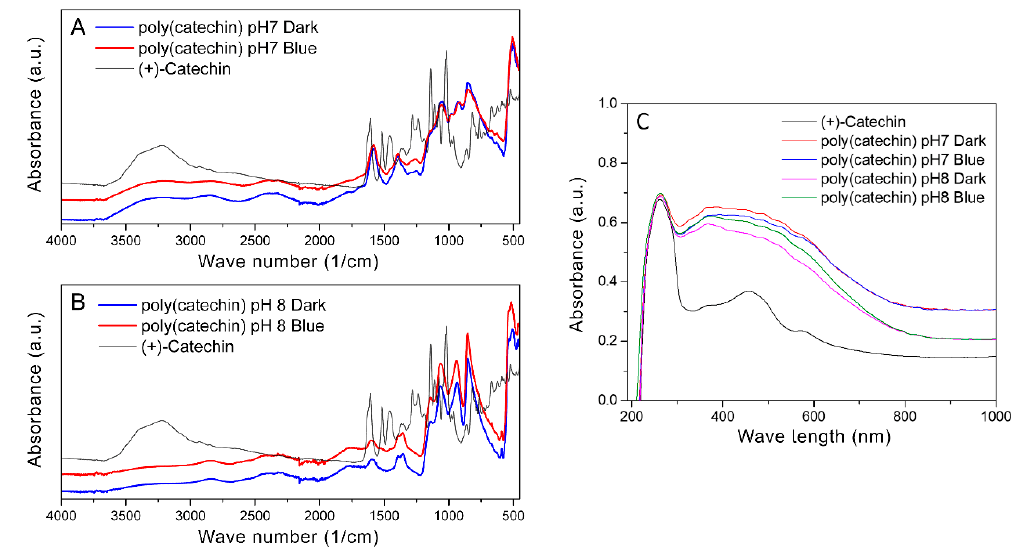
Figure 3. FTIR (Fourier-transform infrared spectroscopy) spectra of poly(catechin) powders obtained as a result of polymerization in the dark in phosphate buffer, and photopolymerization with blue light in solutions of pH 7 ( A ) and pH 8 ( B ) UV-Vis spectra of (+)-catechin and poly(catechin) powders ( C ).